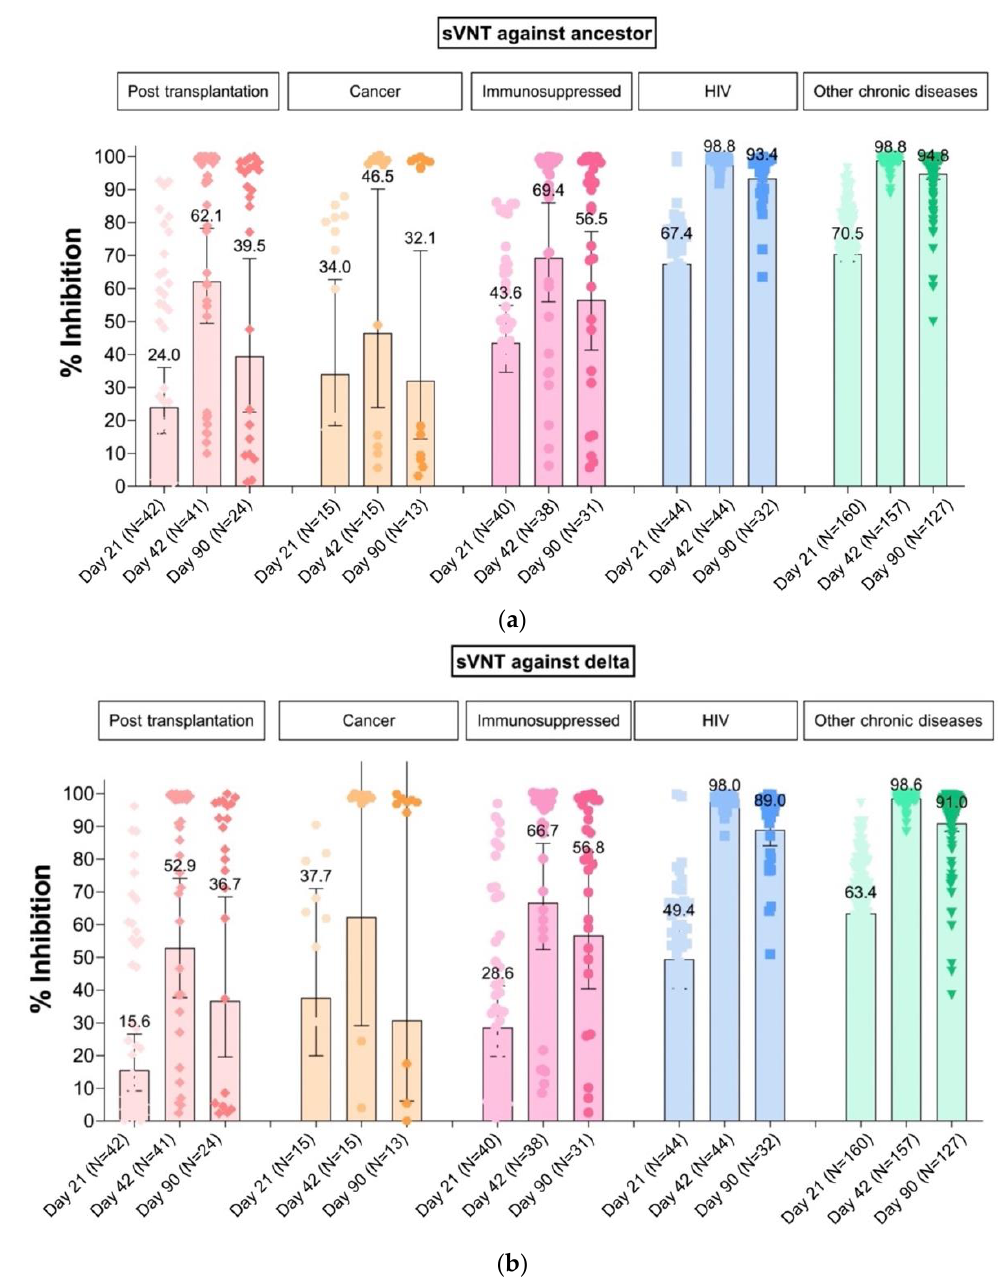
Figure 1. GMs of sVNT among adolescents after BNT162b2 vaccination at day 21, day 42 (14 days after 2-dose of vaccine), and day 90 against the ancestral ( a ) and Delta strain ( b ). Table 2. Surrogate viral neutralizing titer (sVNT) against ancestor and Delta strains after BNT162b2 vaccination among adolescents with chronic diseases.